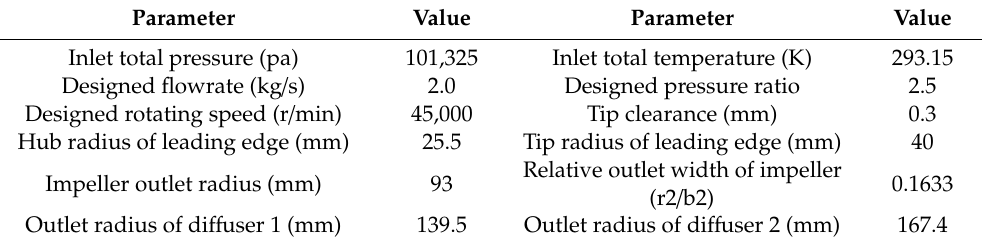
Figure 1. Geometry of the centrifugal compressor: ( a ) the centrifugal impeller, ( b ) the vaneless diffuser. Table 1. Main structural parameters of the centrifugal compressor.